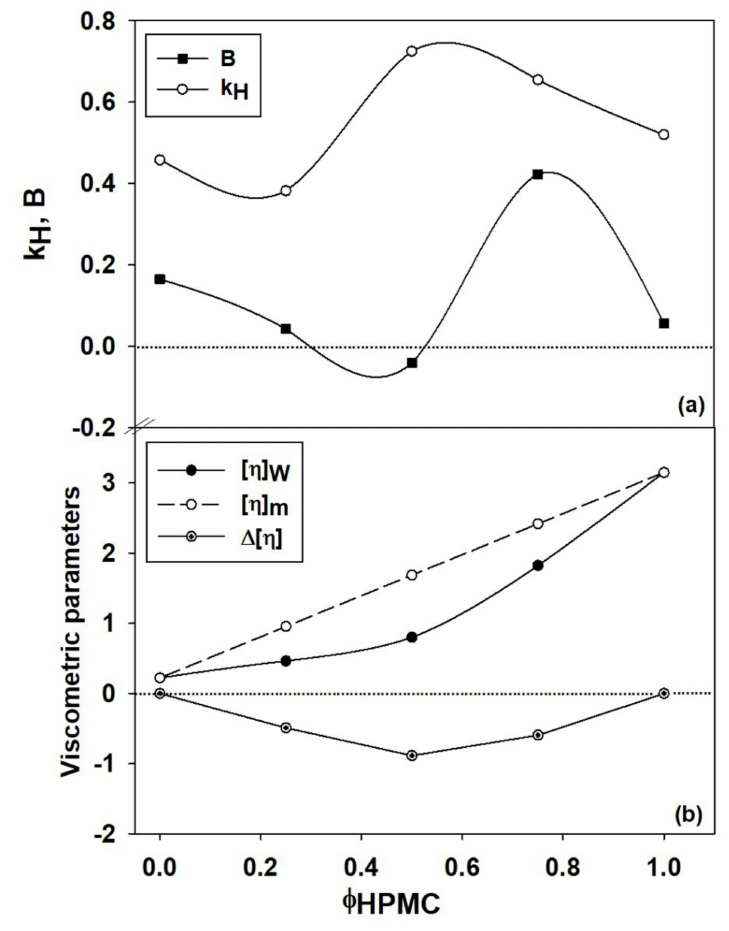
Figure 5. Dependence of k H constant, B parameter ( a ) and of viscometric parameters ( [ η ] [ η ] , ∆ [ η ] ) ( b ) on the volume fraction of HPMC. Dotted line from ( b ) part indicates additive m = ∑ [ η ] φ i rule ( [ η ] id m i